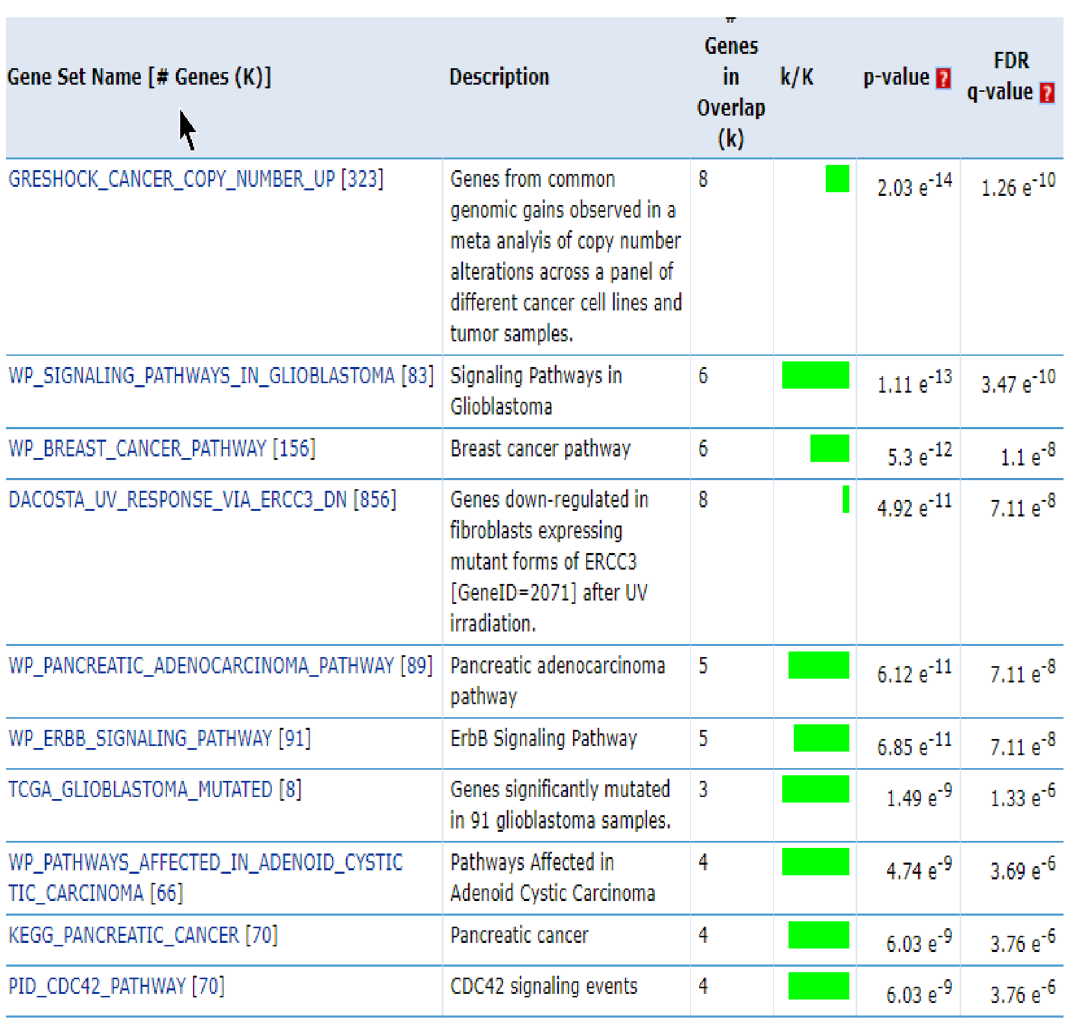
Figure 2. The number of driver genes overlapping with the benchmark dataset in a subset of the top 13 driver